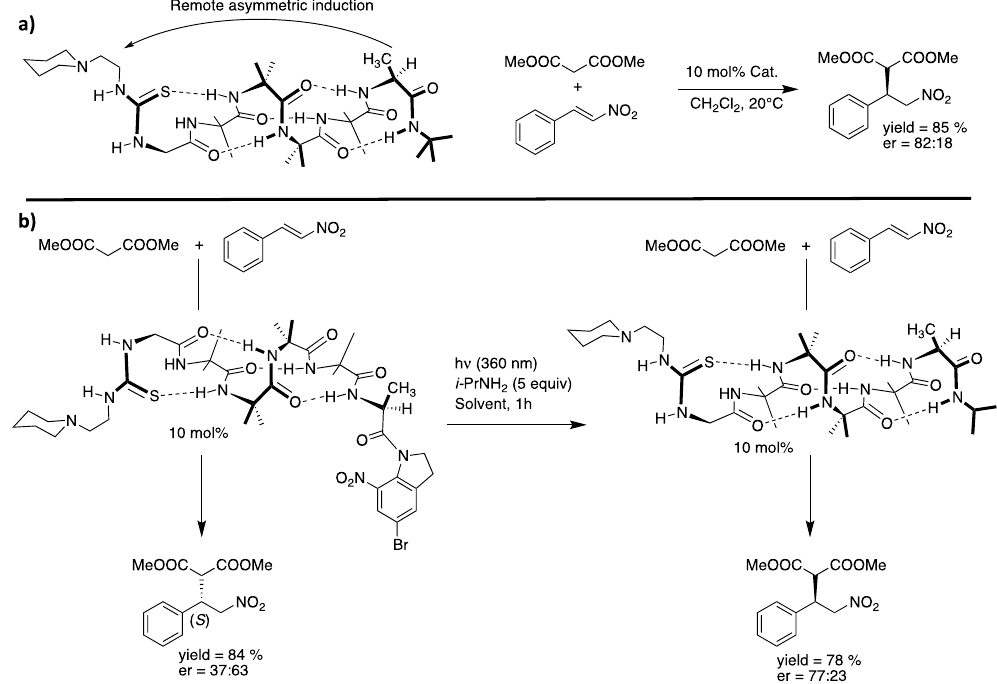
Figure 8. ( a ) Catalytic oligourea with a remotely inducible chiral catalytic site for the nitro-Michael addition reaction of diethylmalonate to β-trans-nitrostyrene. ( b ) Photochemical refolding of a catalytic foldamer with the consequent inversion of the sense of asymmetric induction [121] .